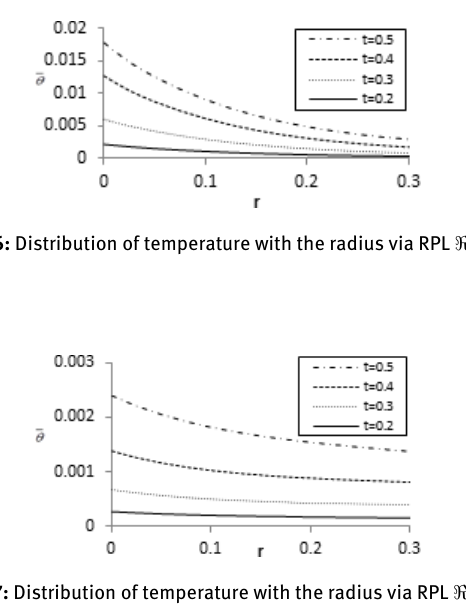
distribution in thermopiezoelastic functionally graded rod against the radius of rod for different values of time param- eter t in RPL model is detected in Figure 6 and Figure 7. The temperature distribution is follows diminish nature for in- creasing values of radius of rod for different values of time parameter t in both RPL ( ℜ = 2 and ℜ = 4) models. The temperature distribution creates sensible consideration for increasing value of in RPL model.